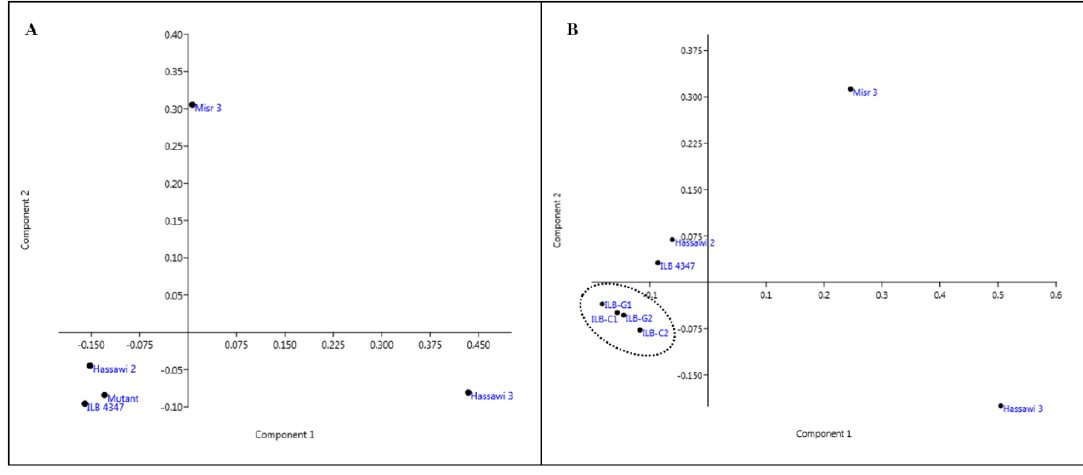
Figure 4. Relatedness among mutant populations and the four reference genotypes. ( A ) Two-dimensional principal component analysis (PCA) of mutant population and the four reference genotypes. ( B ) PCA of the four mutant populations and the four reference genotypes, for the first and second components, based on Nei’s genetic distance data. Mutant: All mutant plants, ILB-G1: mutant population treated by 25 Gy gamma radiation, ILB-G2: mutant population treated by 50 Gy gamma radiation, ILB-C1: mutant population treated by 0.01% DES, ILB-C2: mutant population treated by 0.05% DES.